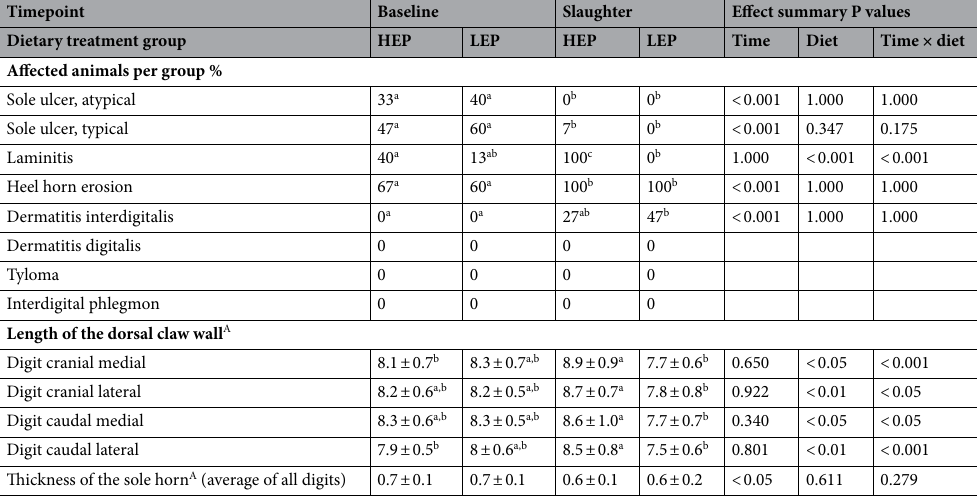
Table 4. Claw disease and size at the beginning of the trial (baseline, 13 months of age) and at slaughter (20 months of age). A Means ± SD, n = 15. Values in cm; a,b,c Levels not connected by the same letter are significantly different (P < 0.05).